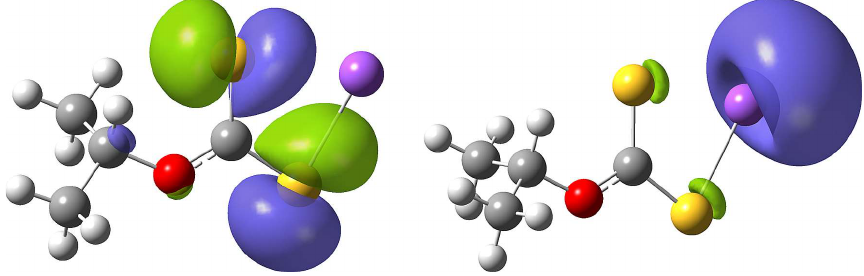
Figure 3. The HOMO ( left ) and LUMO ( right ) of Na-iPrX mapped on isovalue of 0.04 a.u. The HOMO and LUMO of HMFA are more delocalized, compared to Na-iPrX (Figure 4).